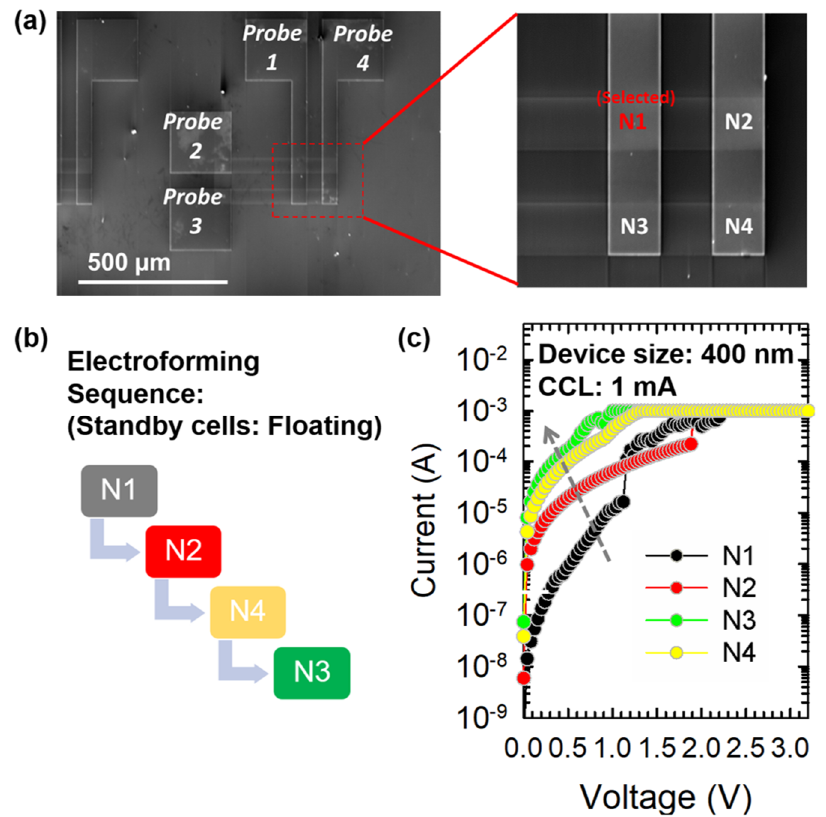
Figure 2. ( a ) SEM image (top view) of the 2 × 2 crossbar array and voltage is applied on the N1 cell, ( b ) electroforming sequence of N1, N2, N4, N3, ( c ) I-V characteristics of HfO x (6 nm) single-layer device in the forming sequence of N1 → N2 → N4 → N3 (size: 400 nm × 400 nm, CCL of 1 mA).